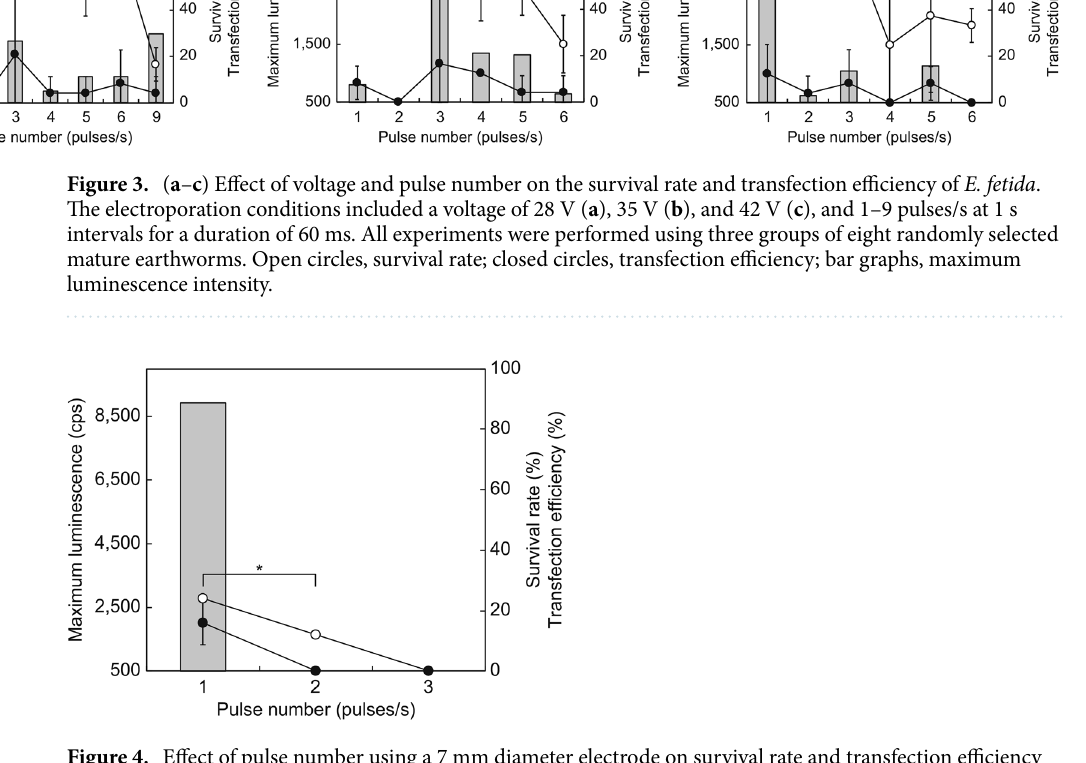
Figure 4. Effect of pulse number using a 7 mm diameter electrode on survival rate and transfection efficiency of E. fetida . The electroporation conditions were 35 V, 0 s intervals, and a 60 ms duration. All experiments were performed using three groups of eight randomly selected mature earthworms. Open circles, survival rate; closed circles, transfection efficiency; bar graphs, maximum luminescence intensity. * p <